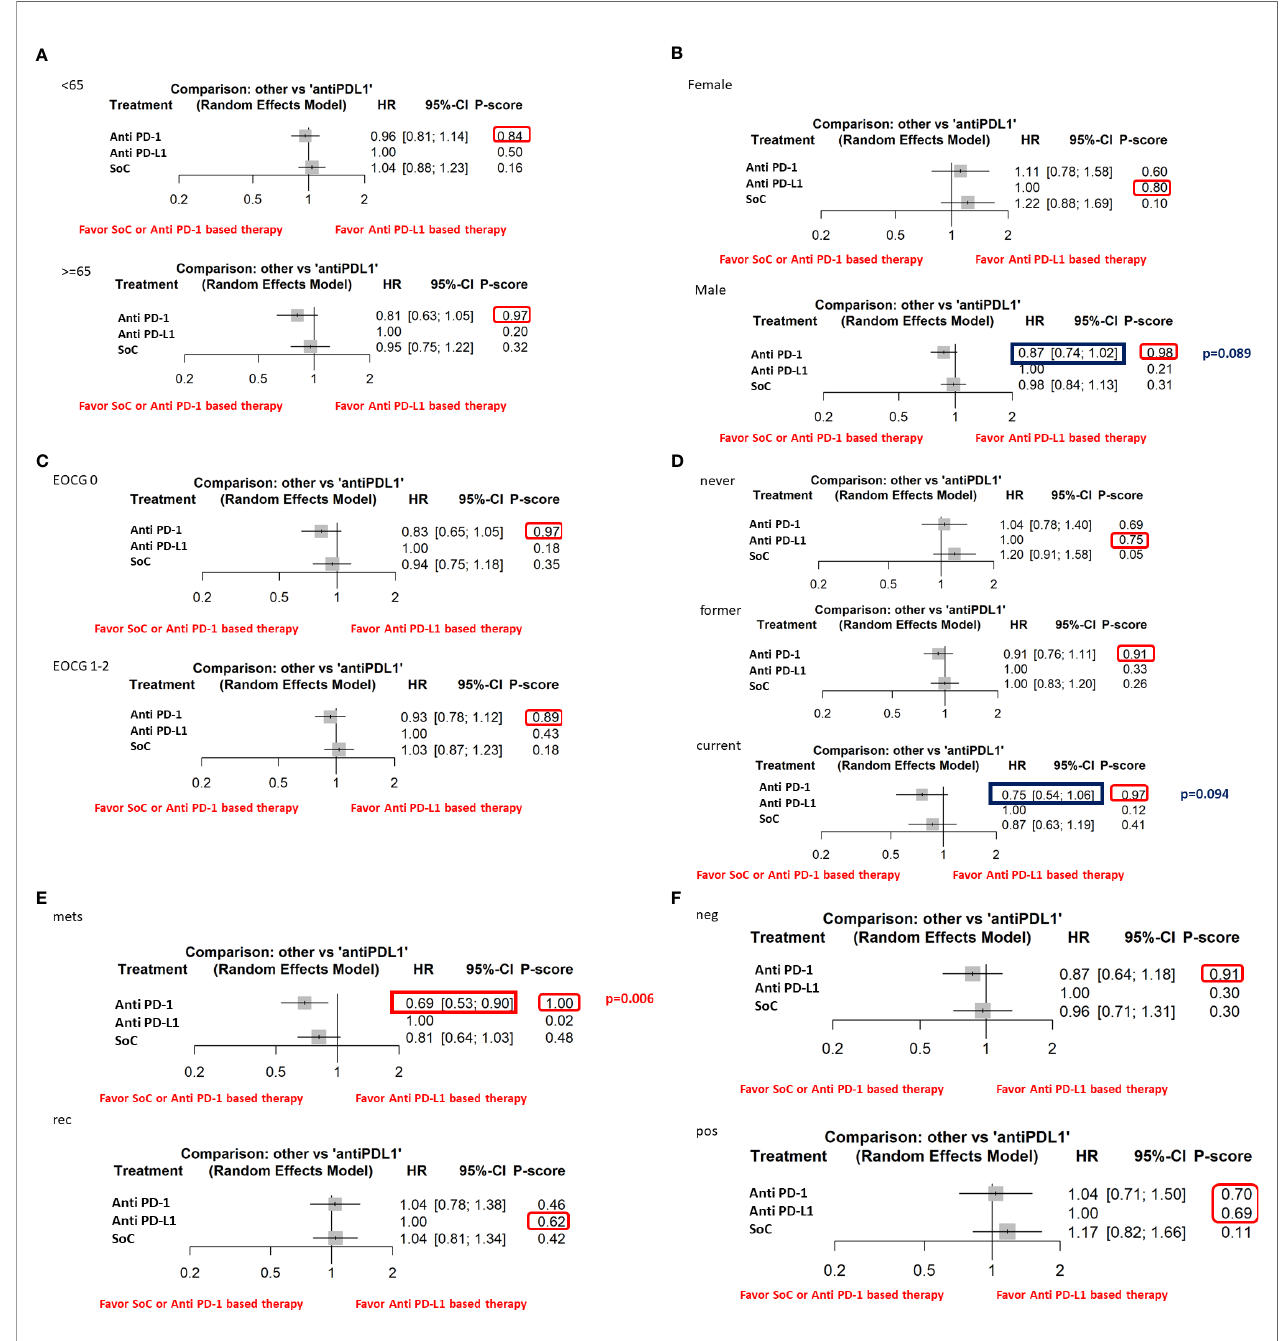
FIGURE 3 | The NMA results of the indirect ef fi cacy comparison of anti – PD-1-based therapy and SoC with anti – PD-L1-based therapy in all the available subgroups: (A) age, (B) sex, (C) ECOG PS, (D) smoke habit, (E) type of disease, (F) HPV